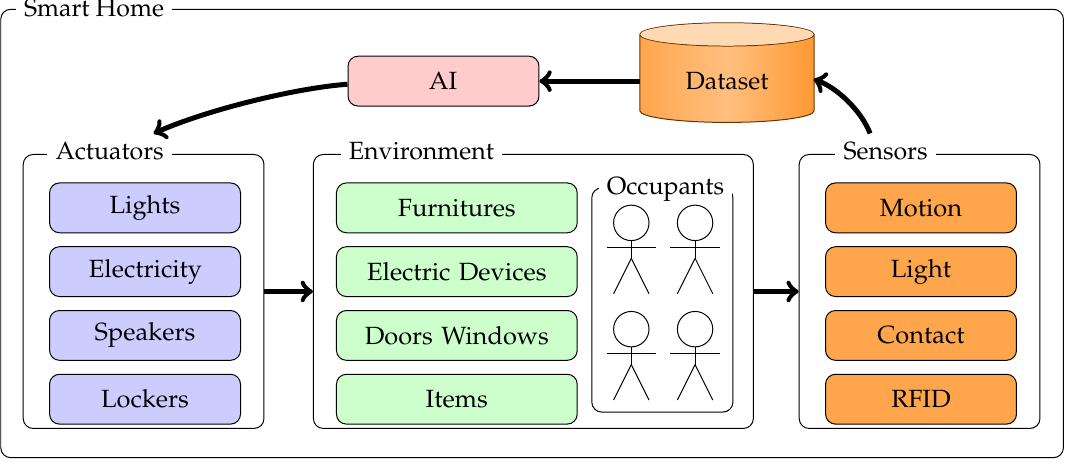
Figure 1. The main components of an intelligent environment (IE). AI: artificial intelligence; RFID: radio-frequency